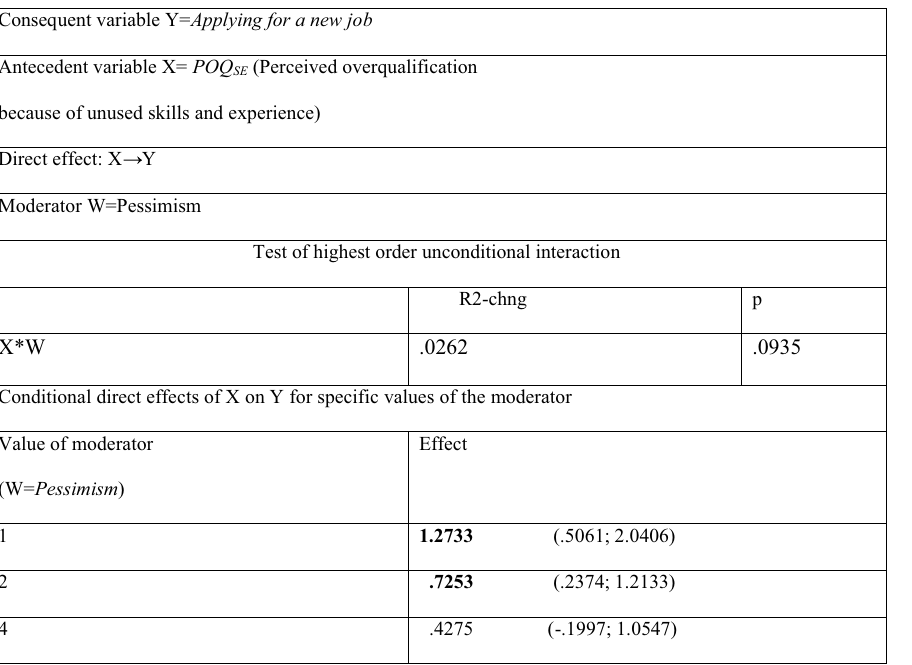
Table 11 Moderated direct effect of POQ (Perceived overqualification because of unused skills and experience) on Applying for a SE new job — Pessimism as a moderator Consequent variable Y= Applying for a new job Antecedent variable X= POQ SE (Perceived overqualification because of unused skills and experience)